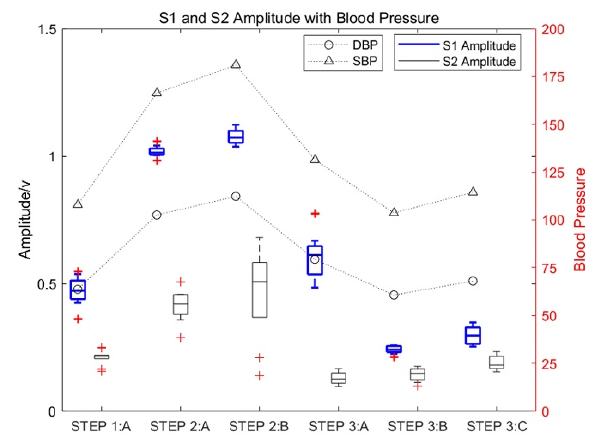
Figure 5. The influence of motion on the amplitude of heart sounds and the corresponding change rules of blood pressure.